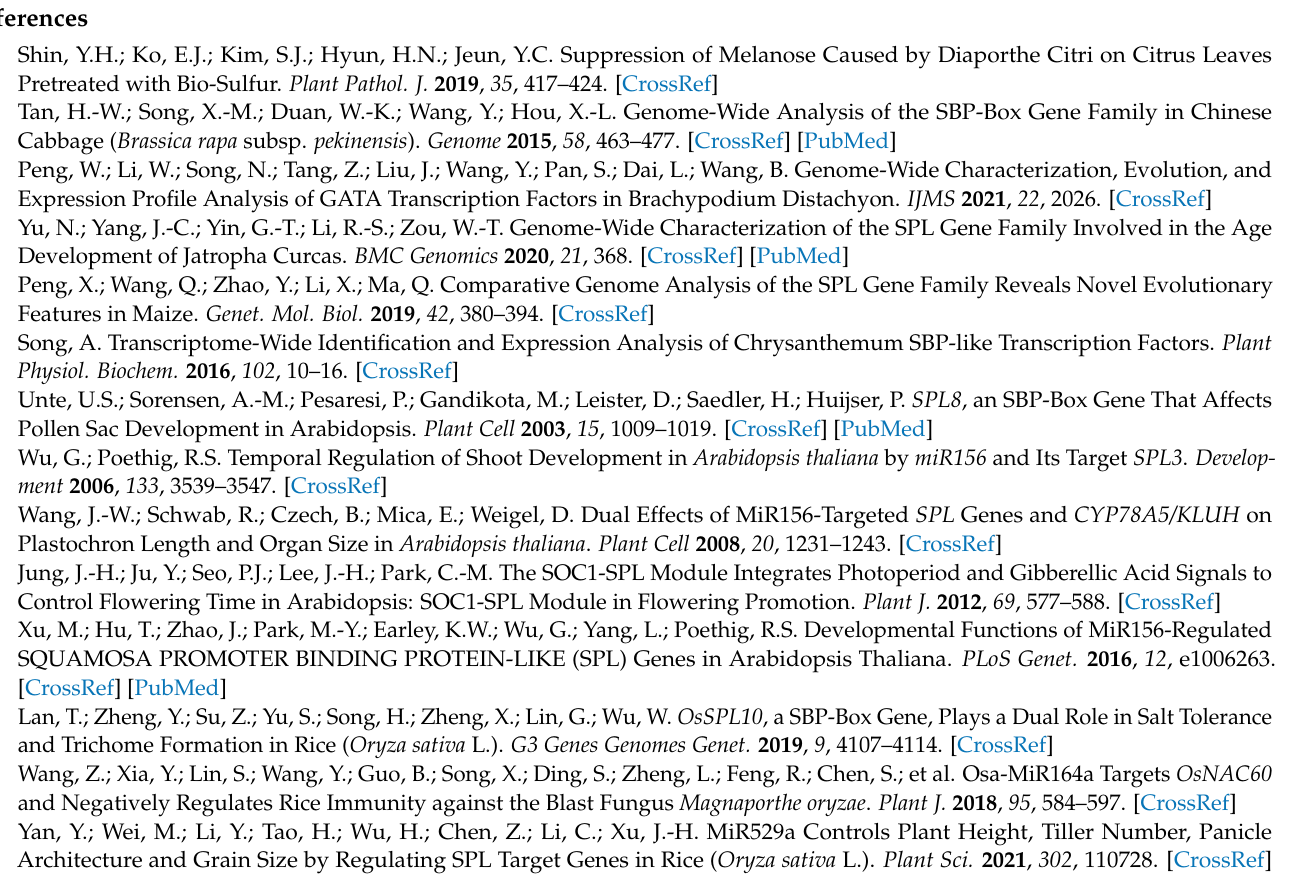
.3390/ijms22168918/s1: Figure S1. Prediction of the tertiary structure of SBP protein. Confidence in the model above 95%. Figure S2. Dot plots of group analysis. (A) Repeat regions of ankyrin repeat domain. (B) Graph of dot plot shows the distinction between different transcripts. Figure S3. Cis-regulatory elements in the promoter of CsSBP genes. Different colors represent distinct putative elements. Table S1. In Silico analysis of CsSBP genes. Table S2. List of SBPs from Citrus sinensis, Oryza sativa, and Arabidopsis thaliana. Table S3. Tandem duplications and segmental of CsSBP gene pairs in Citrus sinensis. Table S4. Synteny analysis between Citrus sinensis and Arabidopsis thaliana and Oryza sativa. Table S5. The sequence and the predicted cis-elements of CsSBP promoter region. Table S6. miRNA targets of CsSBP genes. Table S7. qRT-PCR primers in this